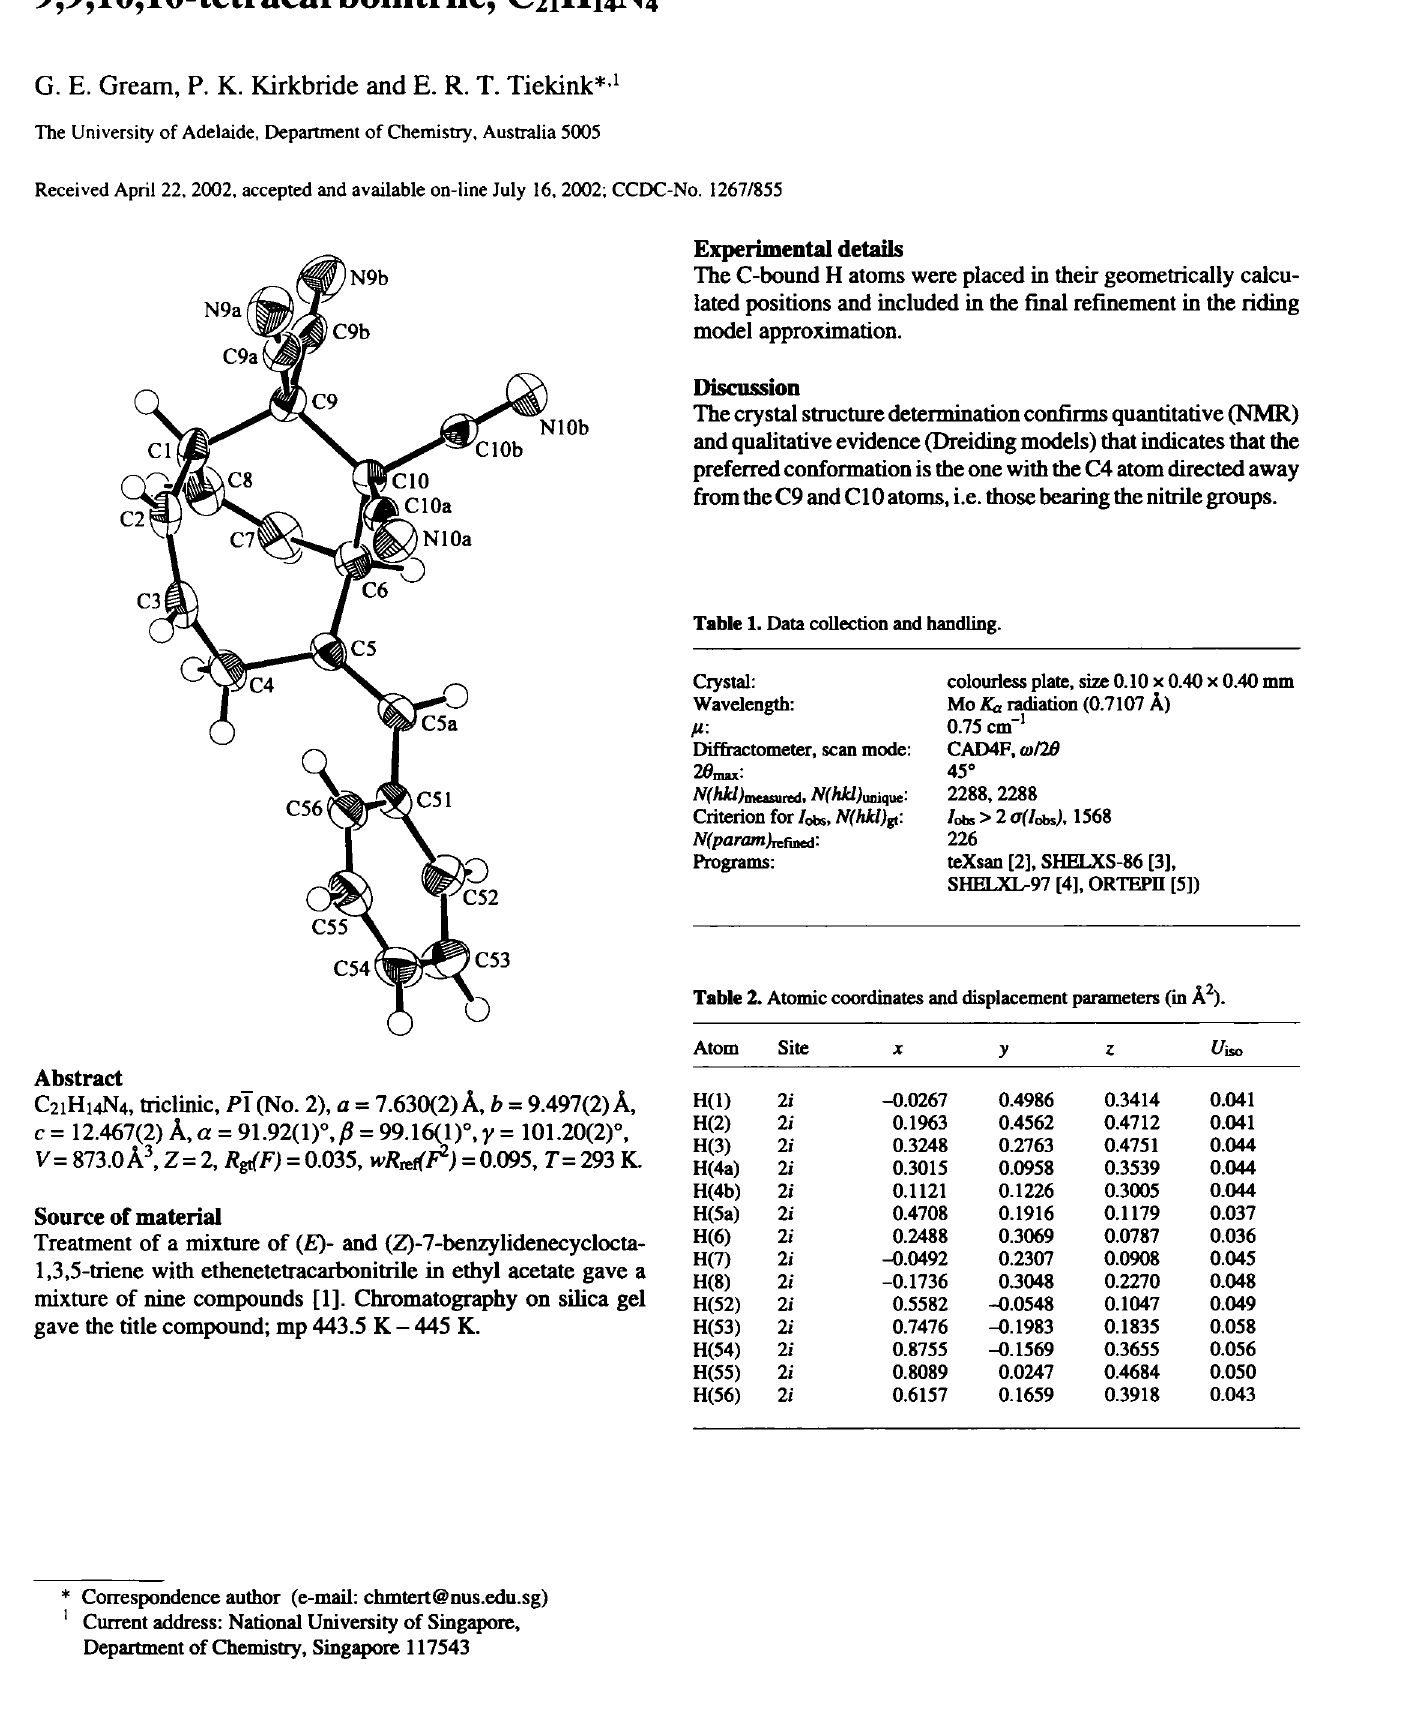
Table 2. Atomic coordinates and displacement parameters (in Â 2